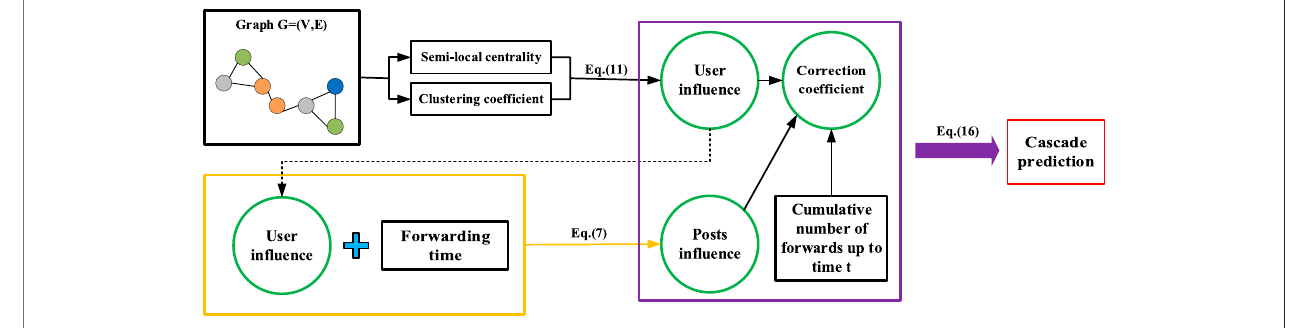
FIGURE 1 | Overview of the proposed framework.